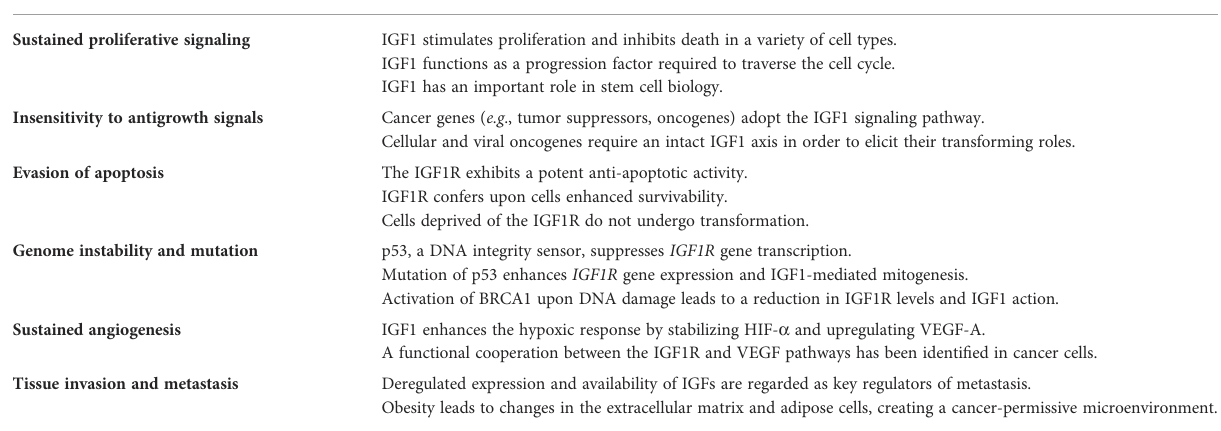
TABLE 2 Hallmarks of cancer and the IGF1 signaling pathway. CANCER HALLMARK IGF1 INVOLVEMENT Sustained proliferative